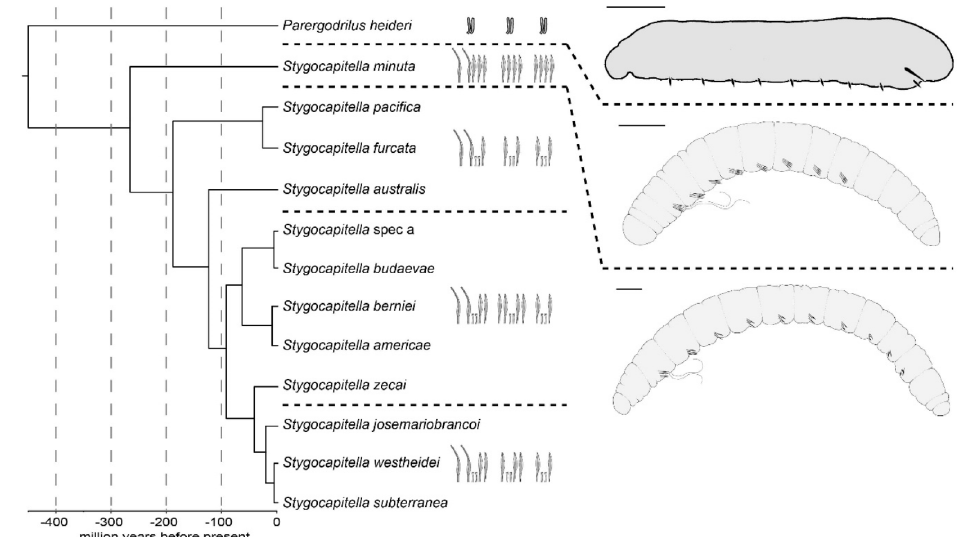
Figure 2. Parergodrilidae based on different sources (Cerca et al. [46]; Cerca et al. [47]; Struck et al. [48]). Besides the species names the different chaetal patterns are shown for the 1st, 2nd and 3rd chaetiger. All following chaetigers have the same pattern as shown for the 3rd. Schematic drawings of the general morphology of Parergodrilus and the two different ones for Stygocapitella are based on Reisinger [33] and Struck et al. [48]. The scale bars equal 125 µ